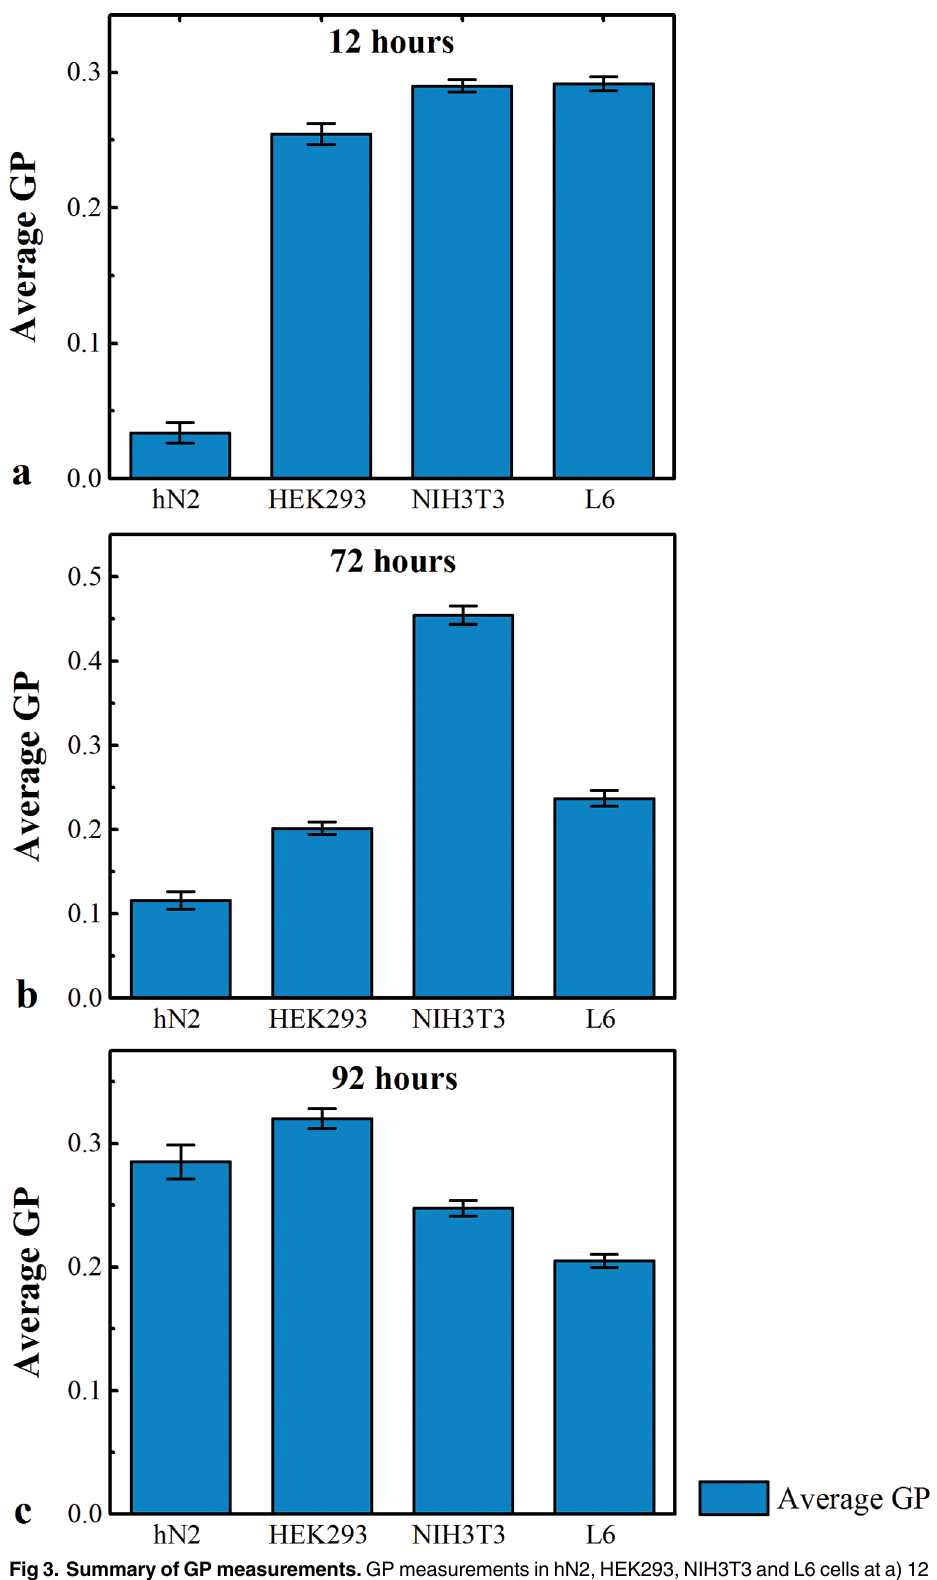
Fig 3. Summary of GP measurements. GP measurements in hN2, HEK293, NIH3T3 and L6 cells at a) 12 h; b) 72 h and c) 92 h. doi:10.1371/journal.pone.0158313.g003 PLOS ONE | DOI:10.1371/journal.pone.0158313 June 30,